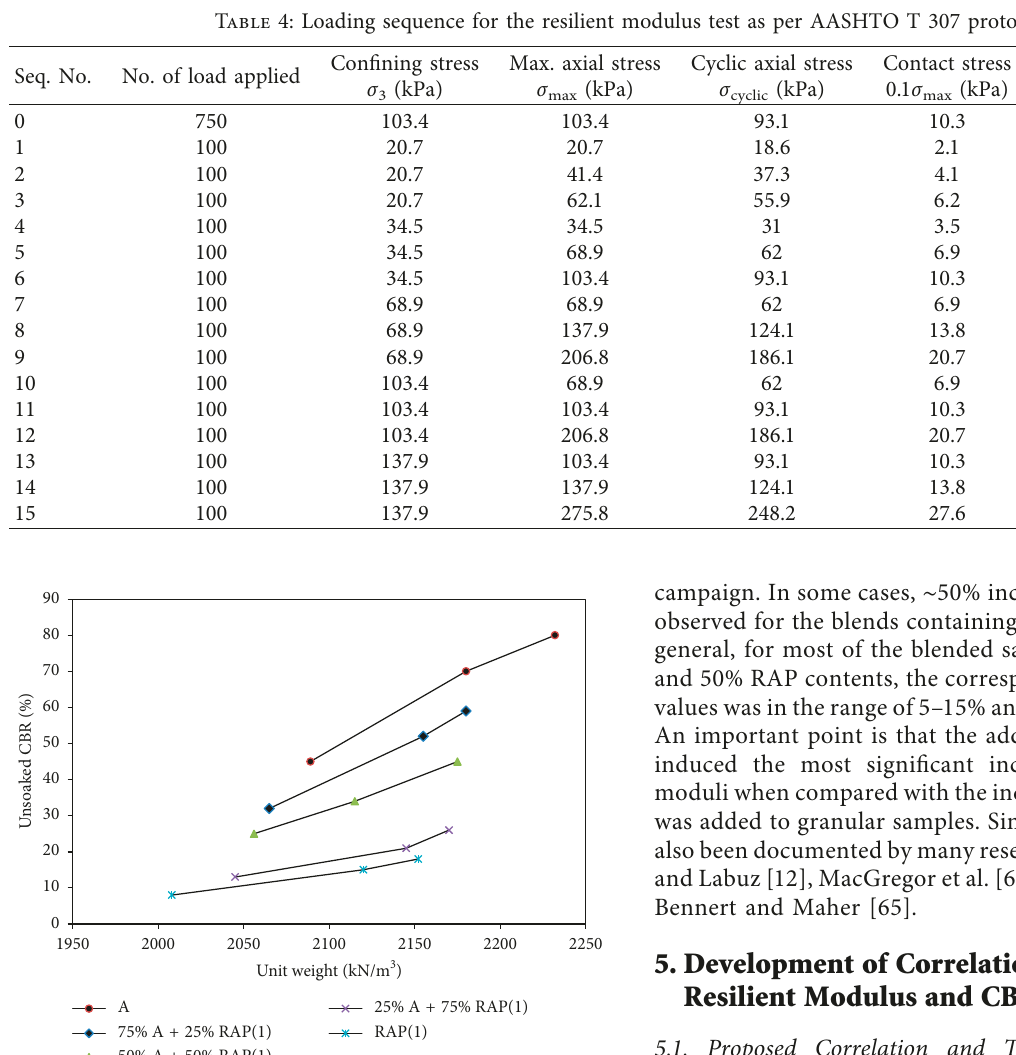
Figure 3: Effect of RAP contents on CBR